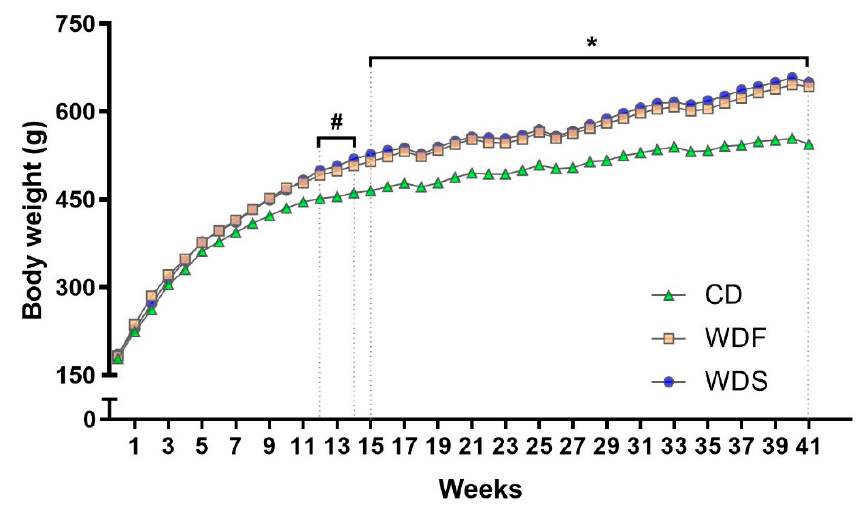
Figure 3. Body weight evolution during dietary intervention with Control diet (CD), Western diet fat (WDF), and Western diet sugar (WDS) for 41 weeks. Data are presented as mean ± s.e.m. Two-way repeated-measures ANOVA and Bonferroni’s multiple comparisons test. # p < 0.05 Control vs. WDS; * p < 0.05 Control vs. WDF and WDS ( n = 10 rats per group).